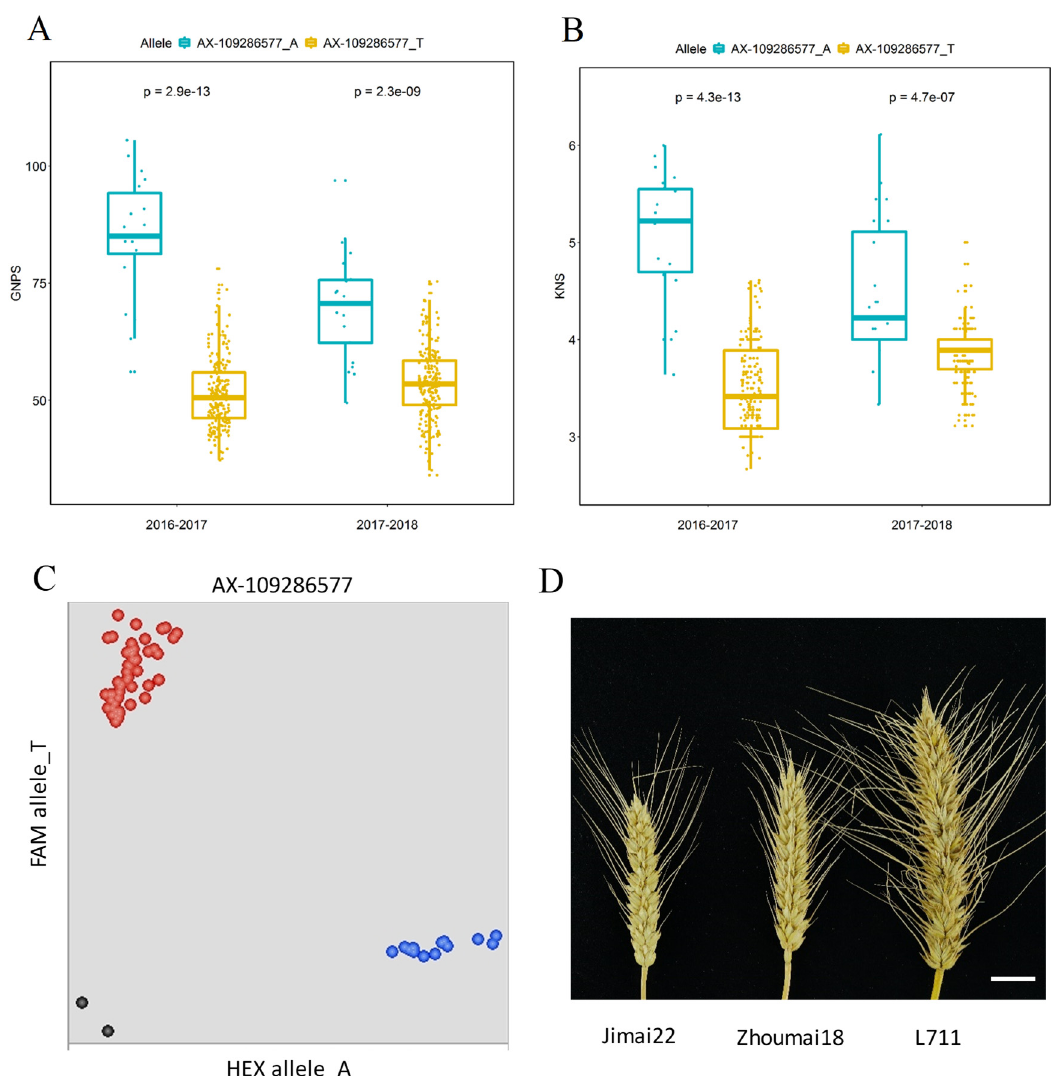
Figure 4. The SNP allele AX-109286577 in the chromosome 4BS genomic region was highly related to the grain number per spikelet trait. Box plot for the SNP allele AX-109286577 related highly to the grain number per spike, i.e., GNPS ( A ) and kernel number per spikelet, i.e., KNS ( B ) traits, respectively. ( C ), the KASP diagnostic marker SNP AX-109286577 was developed, blue circles represent high GNPS materials and red circles represent low GNPS materials. ( D ), Spike morphology comparison of commercial varieties and pre-breeding line L711 (Table S5). Scale bar = 2 cm.